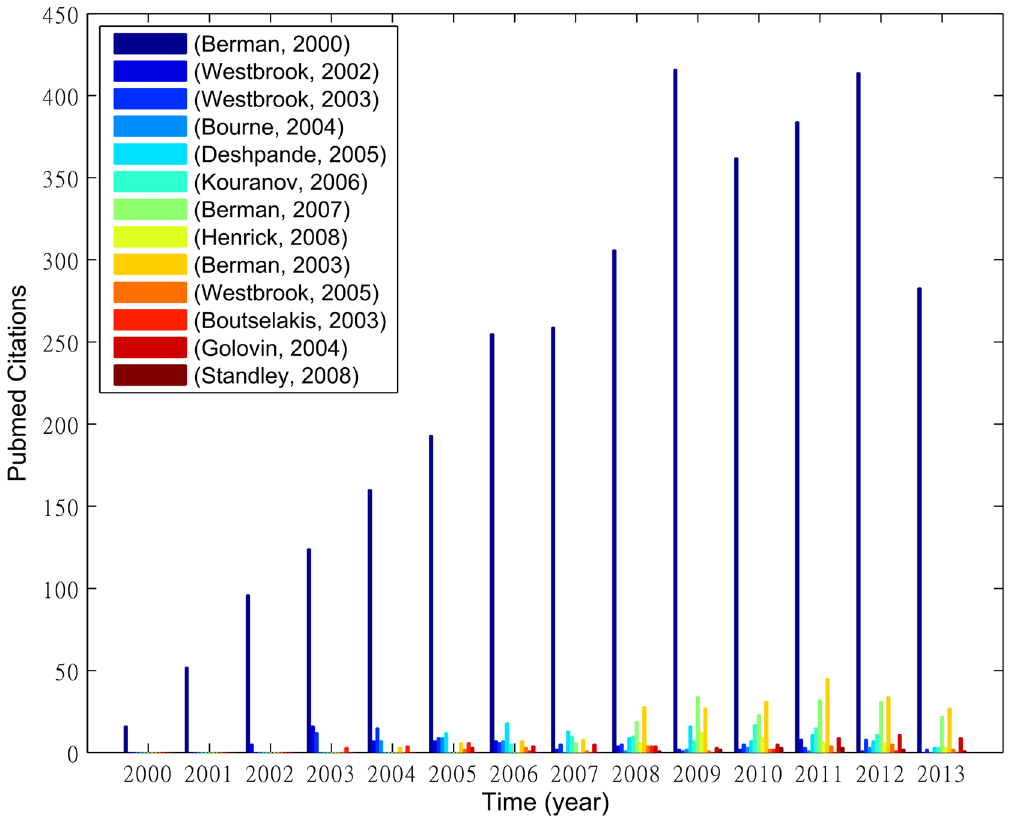
Fig 3. Citation growth of the debut PDB article and its follow-up articles.